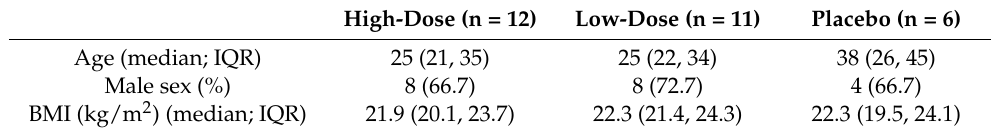
Table 1. Demographic and baseline characteristics.